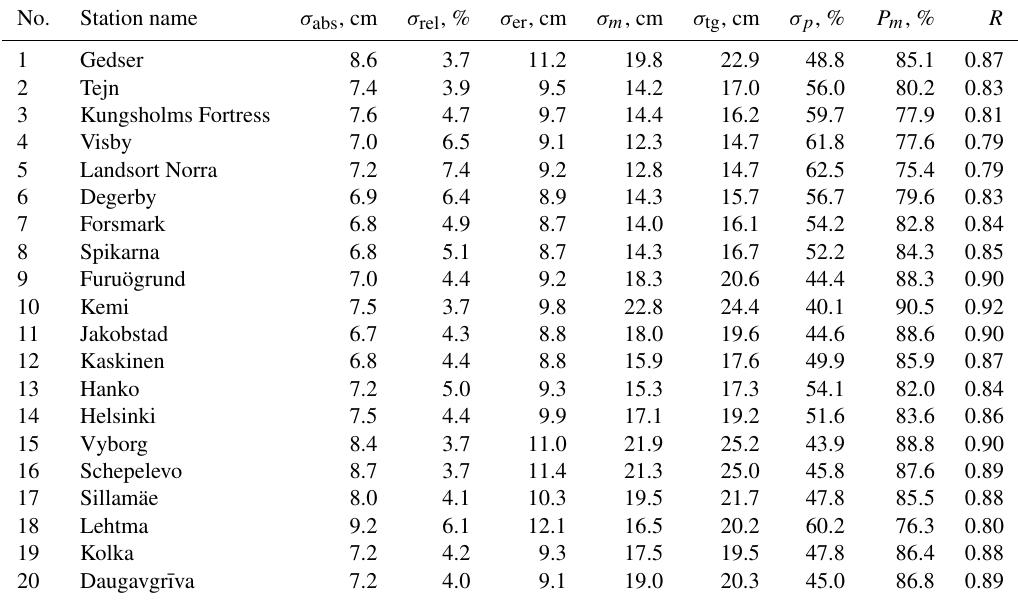
Table 2. Statistical scores evaluating the accuracy of the SSH model simulations.